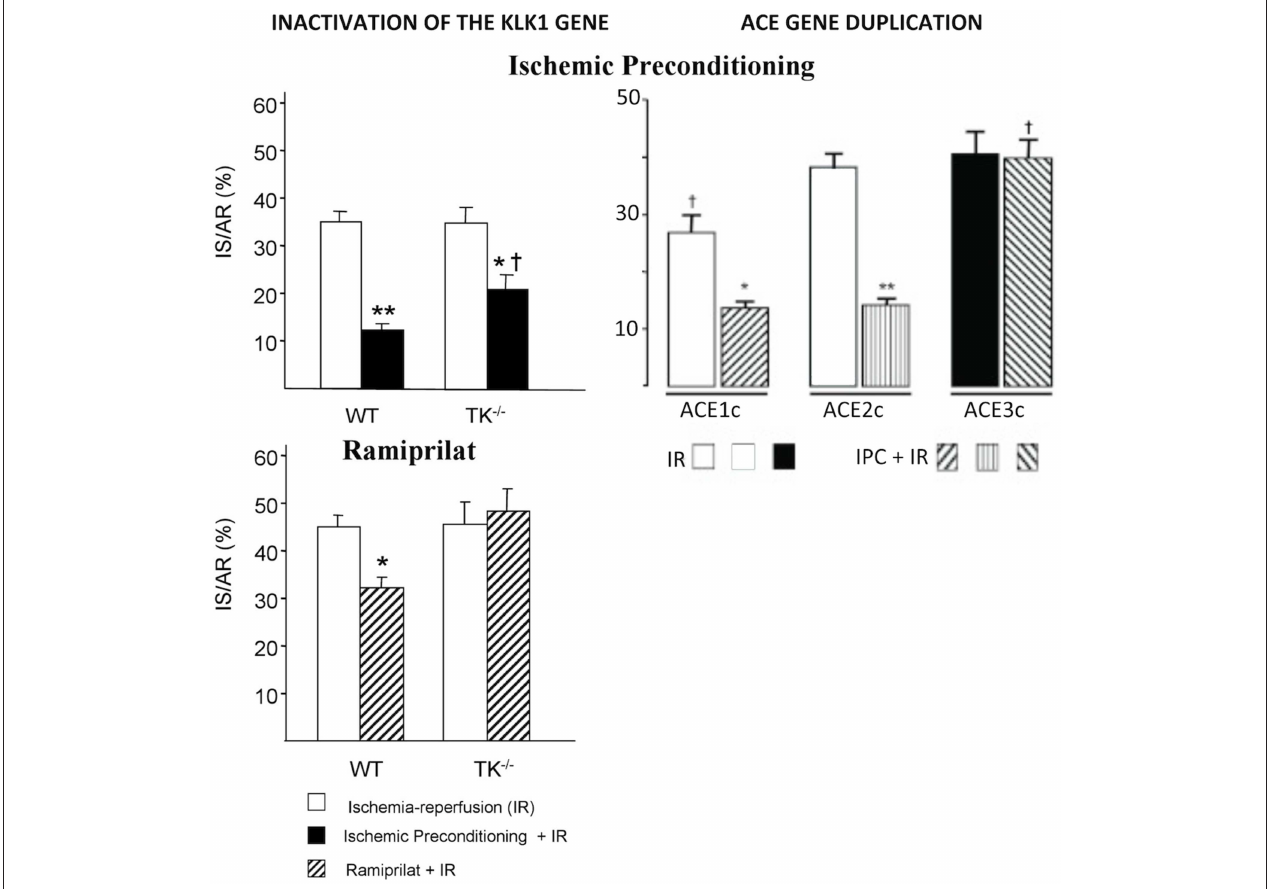
FIGURE 4 | Loss of the cardioprotective effect of ischemic pre-conditioning in mice with an inactivated Klk1 gene or mice carrying a duplication of the ACE gene in cardiac ischemia-reperfusion. IS/AR: infarct size relative to area at risk. IR, ischemia-reperfusion; IPC, ischemic pre-conditioning followed by IR; WT, wild type; TK − / − , K1 deficient mice; ACE1c, mice with a single ACE gene copy; ACE2c, mice with two ACE gene copies (wild type); ACE3c, mice with three ACE gene copies having roughly 140% ACE activity level of wild-type mice. Note also loss of cardioprotective effect of the ACE inhibitor Ramiprilat in K1 deficient mice. * p < 0.05, ** p < 0.01 compared to IR; † p < 0.05 compared to littermate WT or ACE2c (WT). Adapted from Griol-Charhbili et al. ( 55) and Messadi et al.